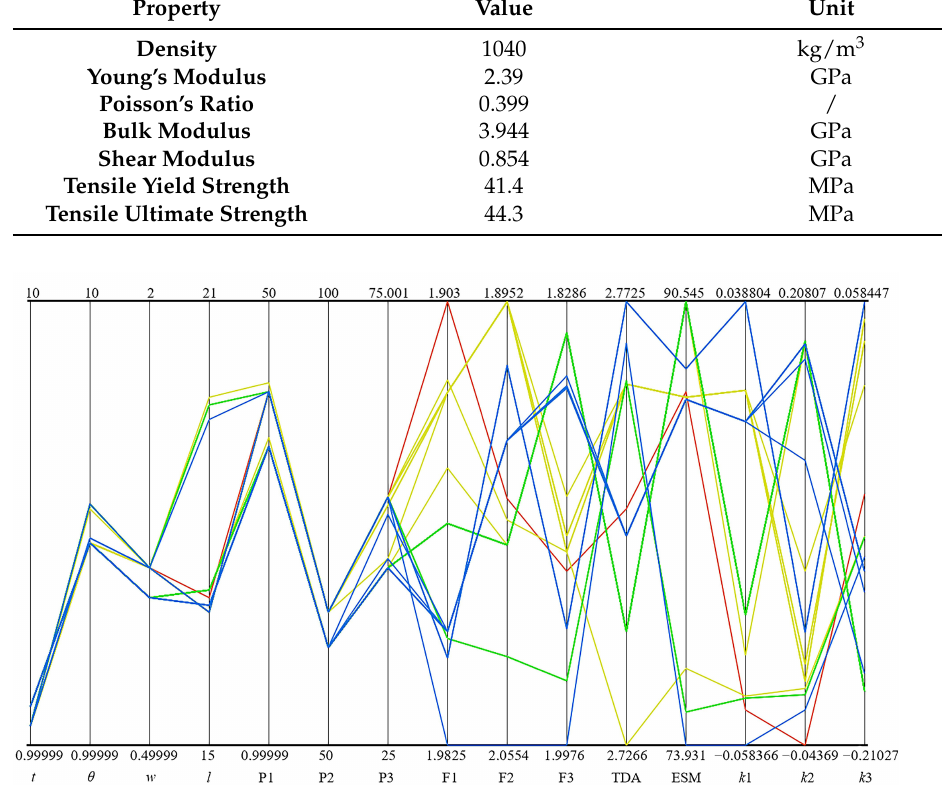
Figure 6. Design point sampling